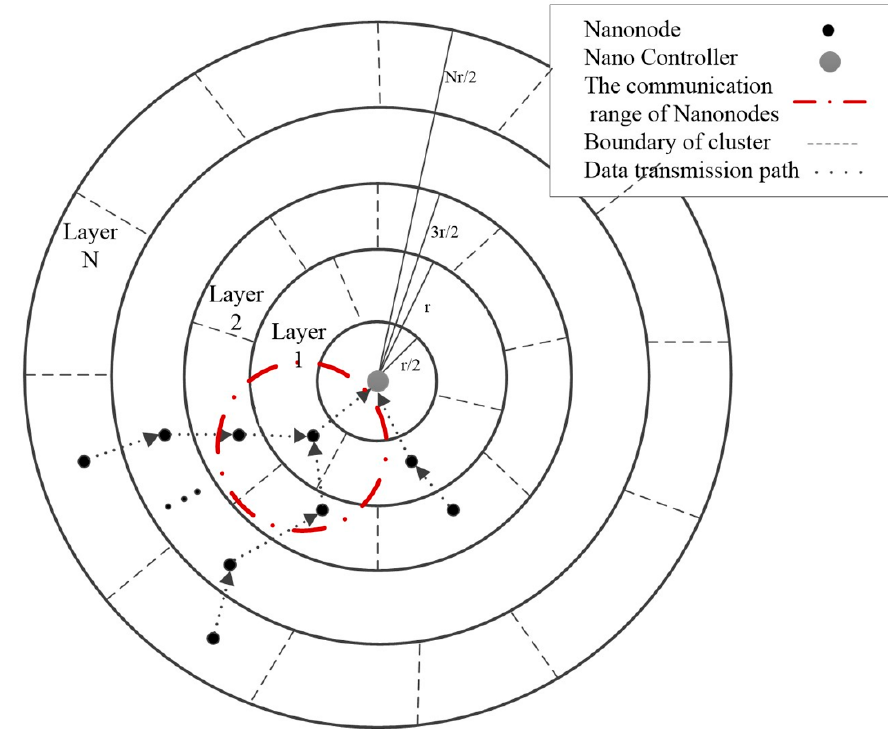
Figure 1. Layered clustering structure of intra-body Wireless NanoSensor (iWNSNs).